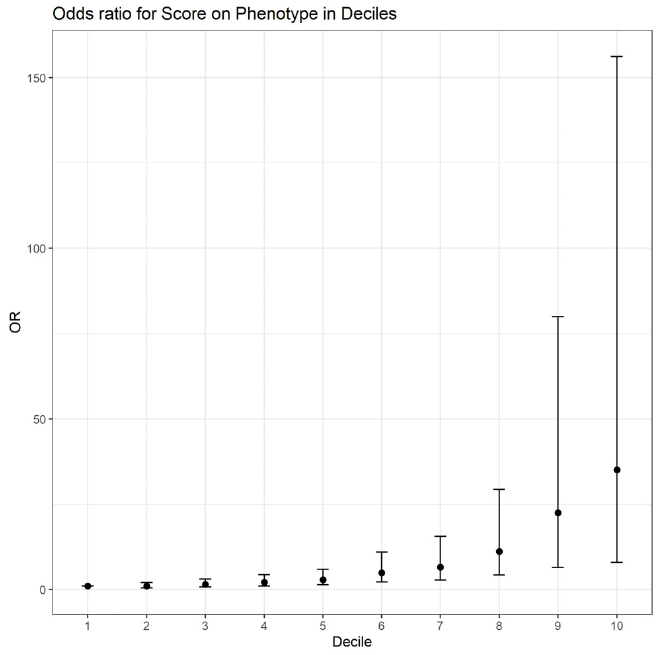
Figure 3. Quantile plot of relative risk of developing AMD. The lowest quantile was set as reference with OR = 1.